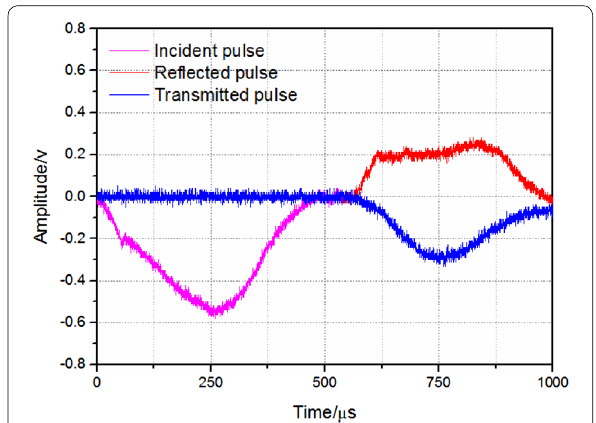
Fig. 3 Typical voltage signals in SHPB test.